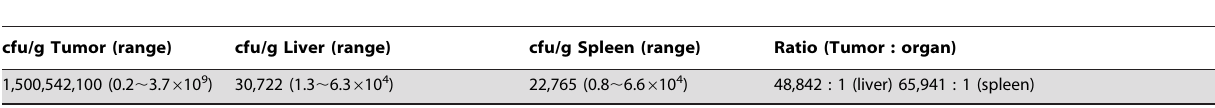
Table 2. Biodistribution of D ppGpp Salmonella typhimurium.